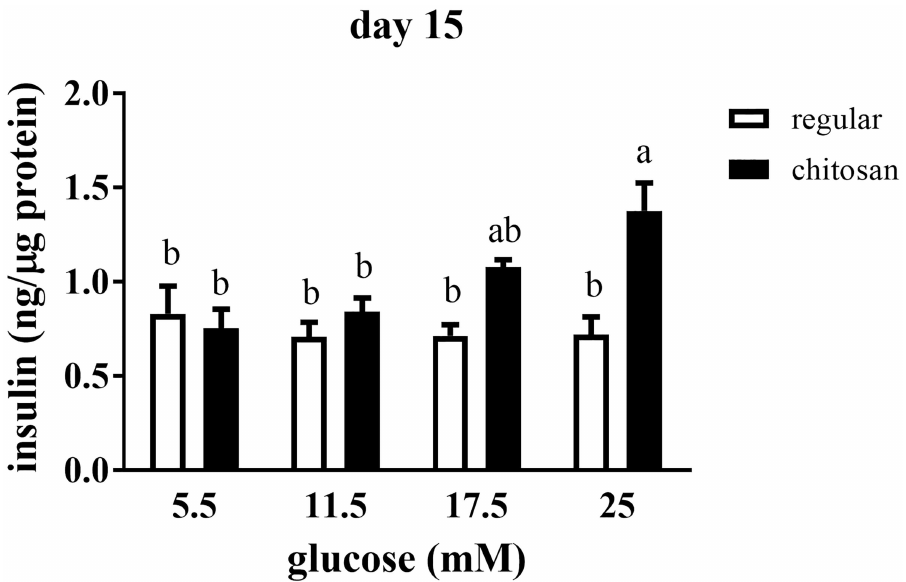
Fig 3. Glucose responsiveness of pADSC-derived insulin-secreting clusters. Quantification of insulin secretionlevel from PILCs in response to a glucose challenge. PILC from day 15 of differentiationwere starved overnightand treated with the indicatedconcentrations of glucosefor one hour. Insulin values were obtained by ELISA analysisas describedin the text, normalized against protein concentrations and expressedas mean ± SEM, n = 6. * , P <